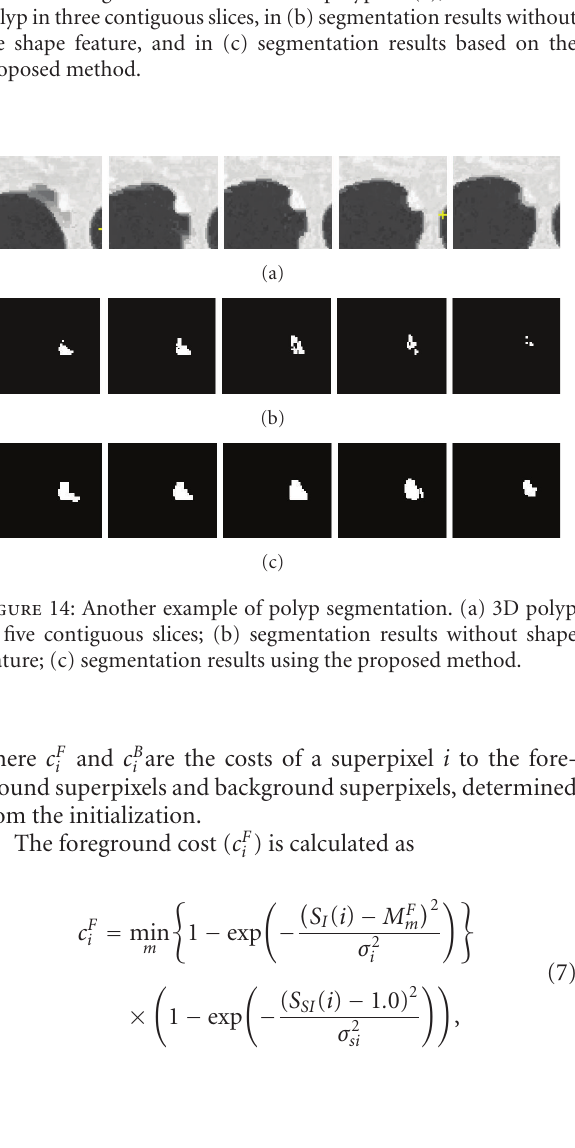
Figure 11: An example of a pleural nodule segmentation. (a) Orig- inal 3D nodule on four contiguous slices; (b) and (c) segmentation results without and with the shape feature (proposed method), respectively.